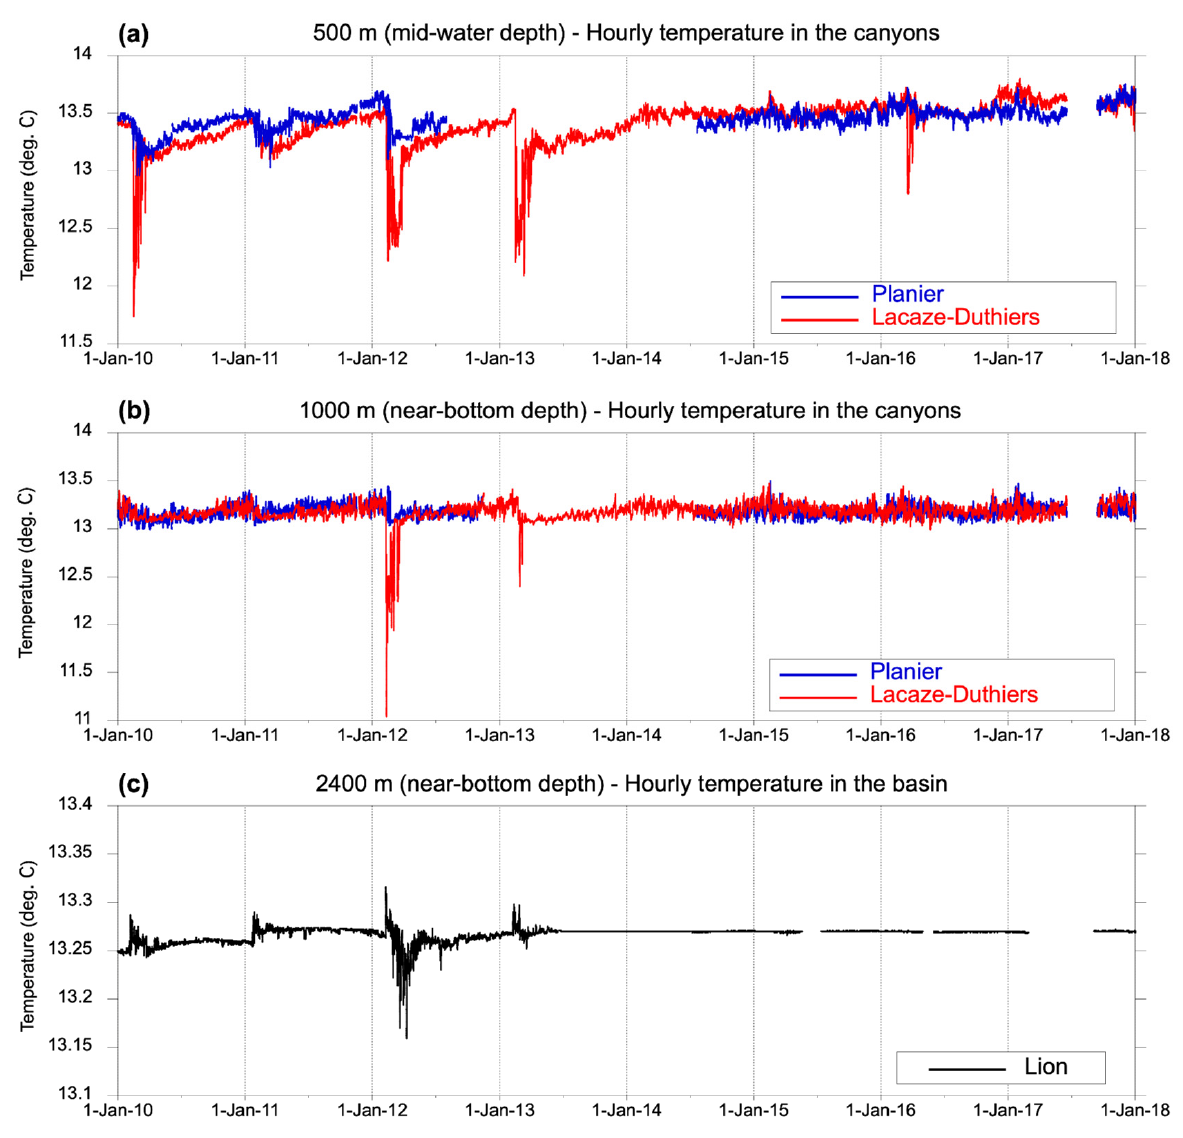
Figure 2. The 2010–2017 hourly time series of temperature ( a ) at 500 m deep (mid-water) in the Planier and Lacaze-Duthiers Canyons, ( b ) at 1000 m deep (near-bottom) in the Planier and Lacaze-Duthiers Canyons, and ( c ) at 2400 m deep (near bottom) in the basin at the Lions site. See Figure 1 for the location of the sites.